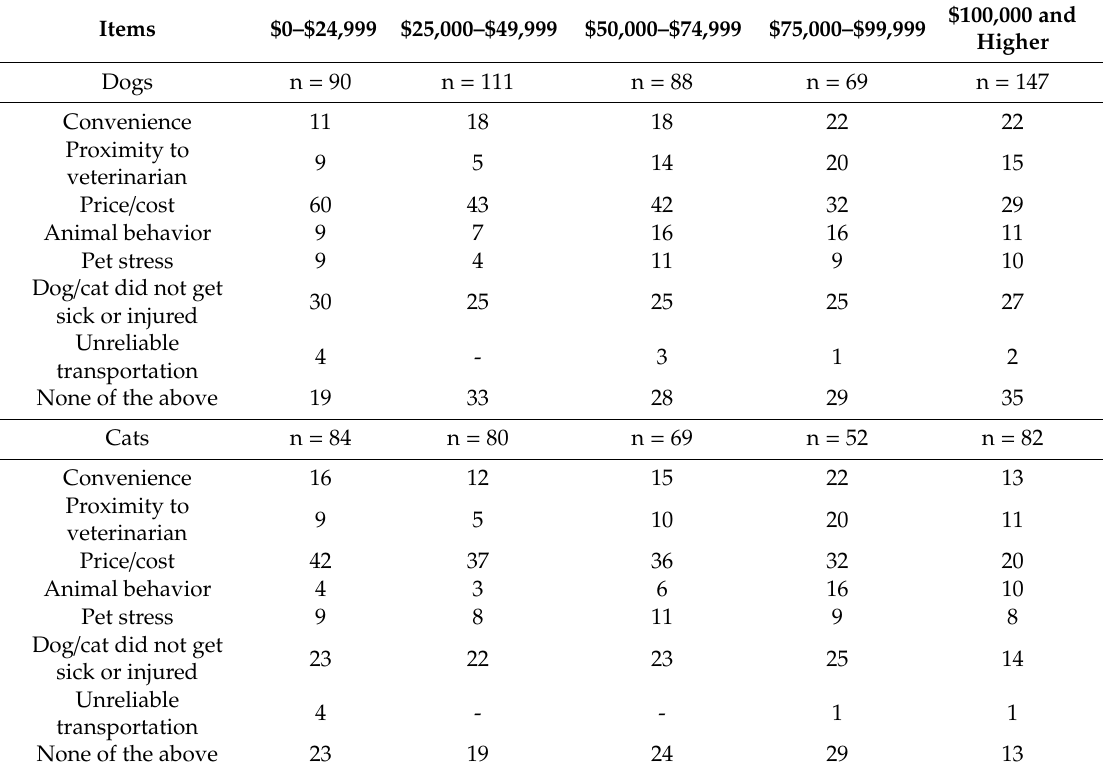
Table A1. Items that prevent (prevented) respondent from seeking veterinary care, by